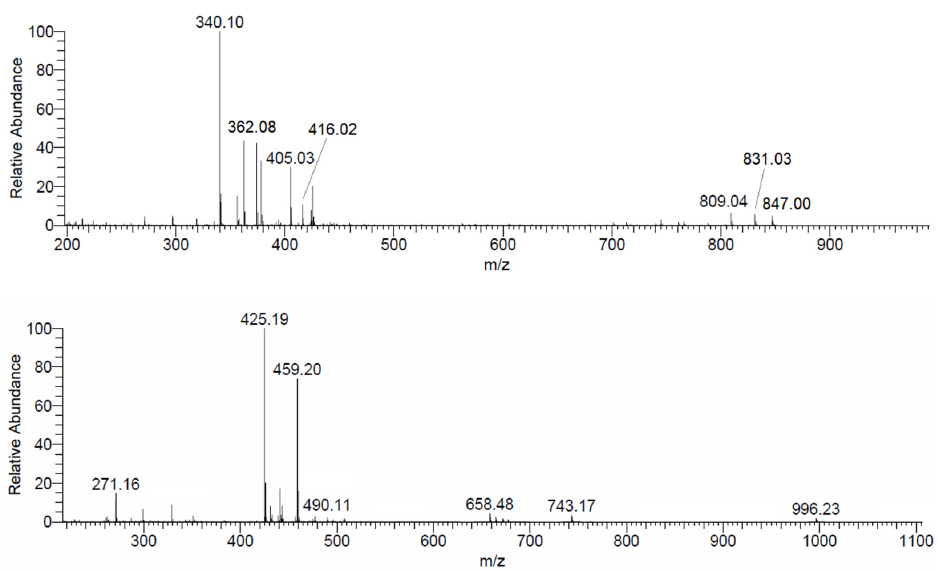
Figure 4. ESI-MS(+) spectrum recorded on the system V IV O 2+ -L4 at 1:1 molar ratio (top) and ESI- MS(+) spectrum recorded on the system V IV O 2+ -L9 (bottom) at 1:1 molar ratio (LC-MS H 2 O, ligand concentration 50 µ M). Table 3. Species identified in the ESI-MS spectra of the systems V IV O 2+ -L4 and V IV O 2+ -L9. Species Composition